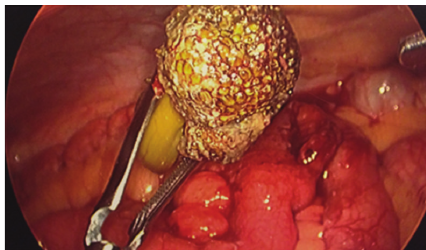
Figure 5: Large 5 cm × 6 cm piece of